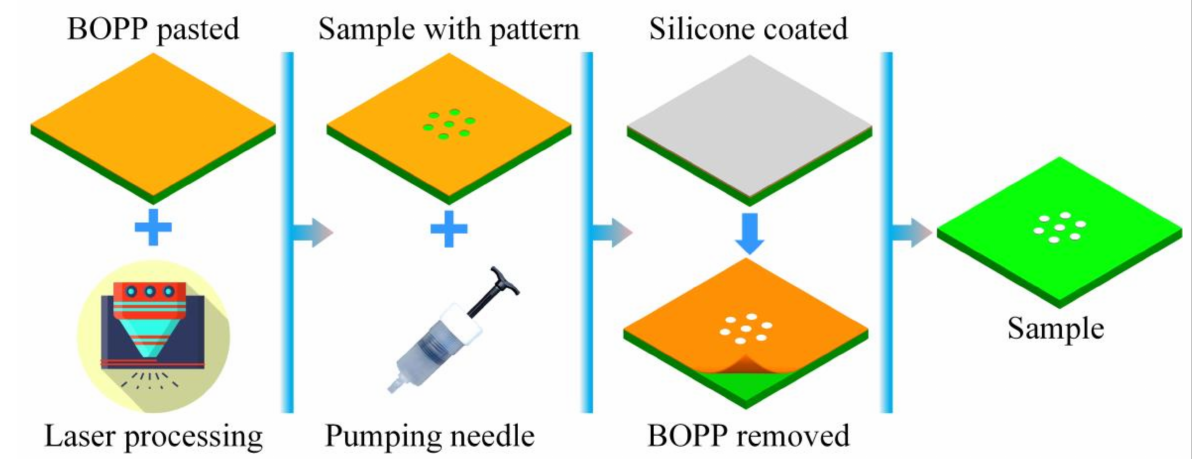
Figure 5. Surface preparation process with discontinuous thermal conductivity.